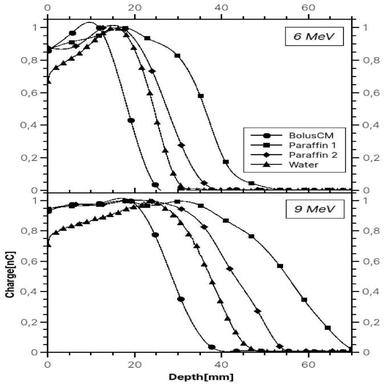
Measured depth dose curves for 6 and 9 MeV electron beams measured for Water and BolusCM, paraffins 1 and 2 boluses.